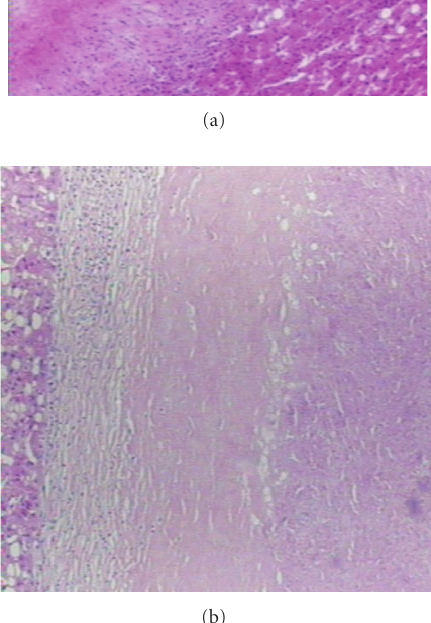
Figure 3: The two patients both had the typical image of SNN (HE × 40). (a) Case1; (b) Case2.